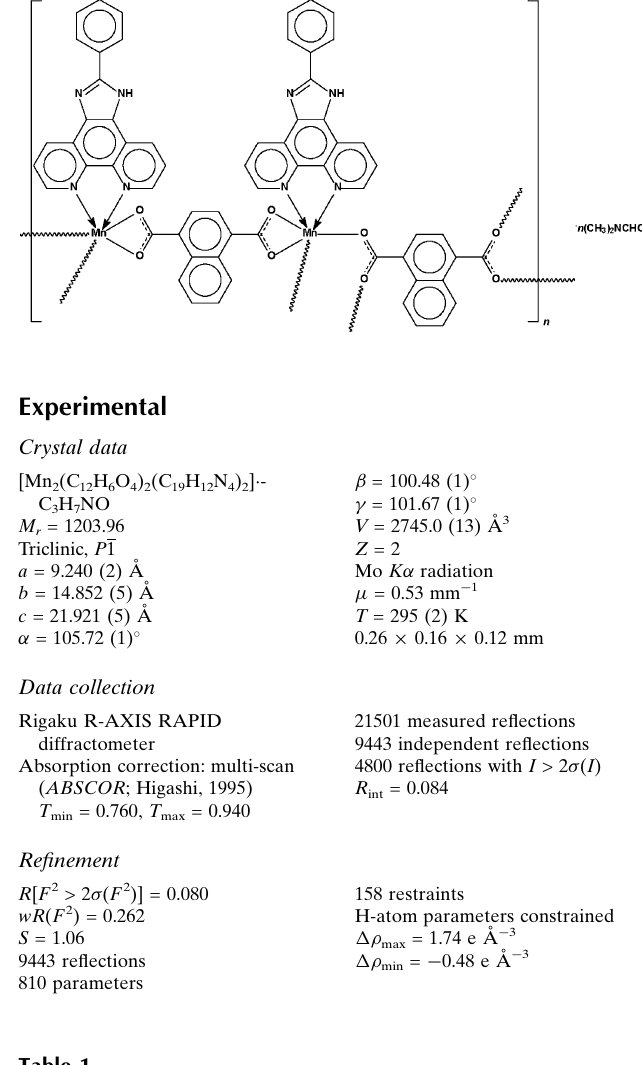
Rigaku R-AXIS RAPID diffractometer